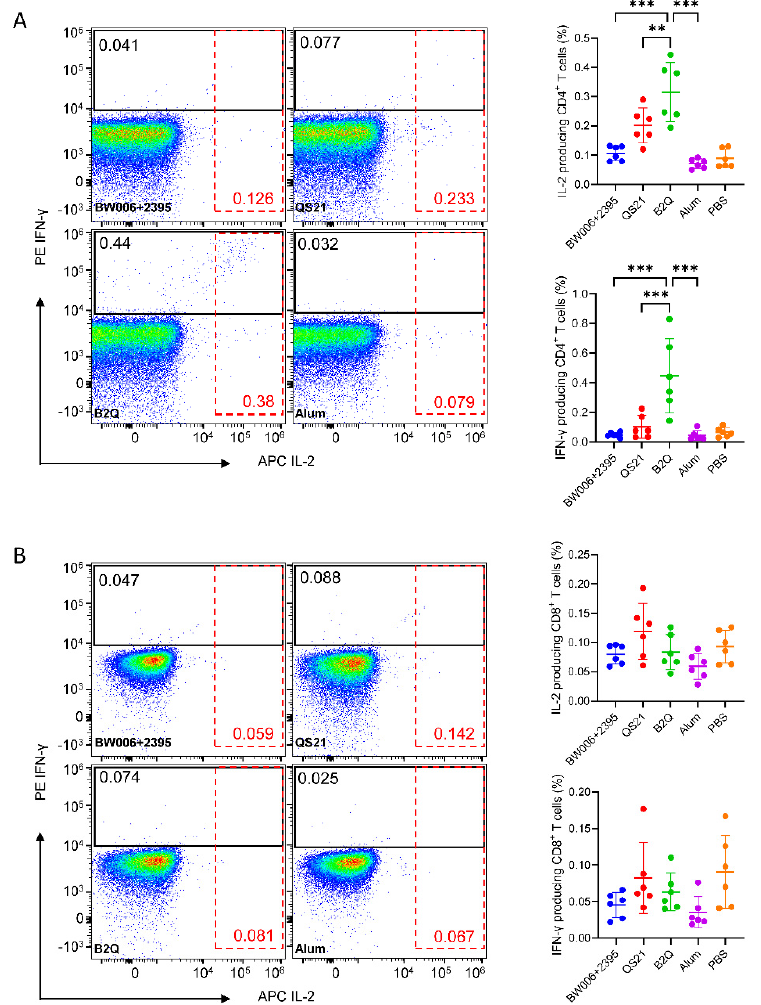
Figure 3. Flow cytometry assay assessing gE-specific cytokine-producing CD4 + ( A ) and CD8 + ( B ) T cells in mice in the adjuvant synergy study. Splenocytes from immunized mice were treated with 10 µg/mL protein gE, and after blocking with brefeldin A, IL-2- and IFN- γ -producing CD4 + ( A ) or CD8 + ( B ) T cells were detected. Pseudocolor images displaying representative results near the average value are presented in the left panel. N = 6, points represent individual mice. Data are shown as the mean and SD and were analyzed by ANOVA, with the mean of the B2Q group used as a control. ** p ≤ 0.01; *** p ≤ 0.001.